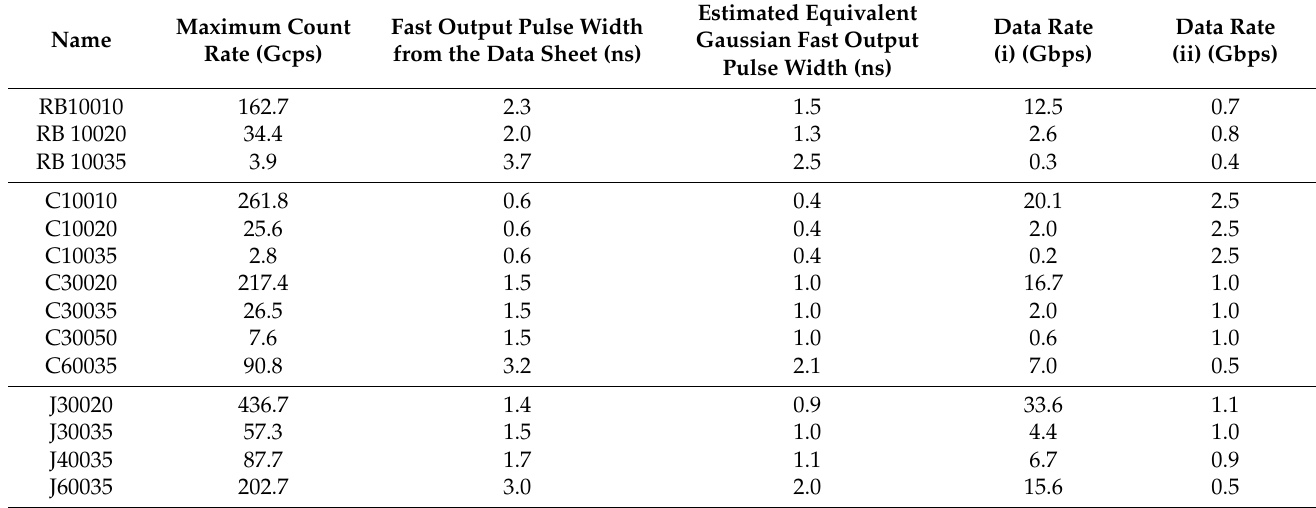
Table 2. Two important parameters of the onsemi SiPMs together with the data rates determined by the two criteria described in the